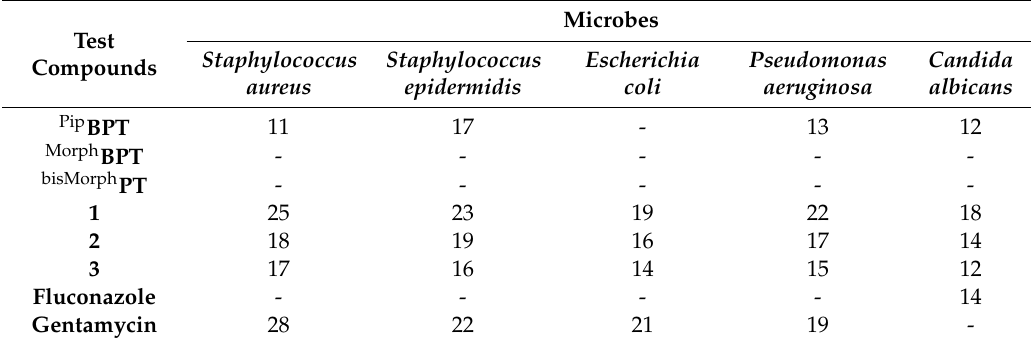
Table 5. Anti-microbiological activities of the studied compounds against some tested microbes at 200 µ g by the agar well di ff usion